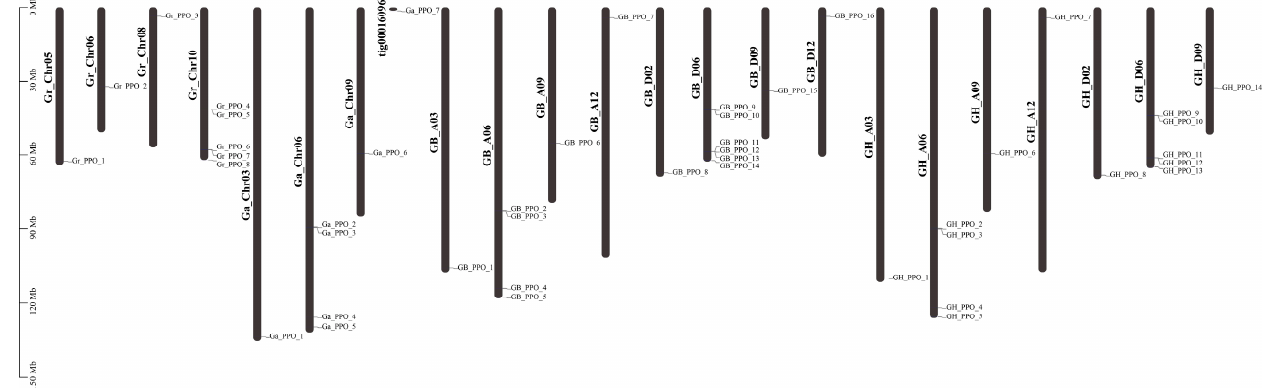
Figure 1. Chromosomal localization analysis of cotton PPO gene members. Y -axis indicates the chromosome length (bp).